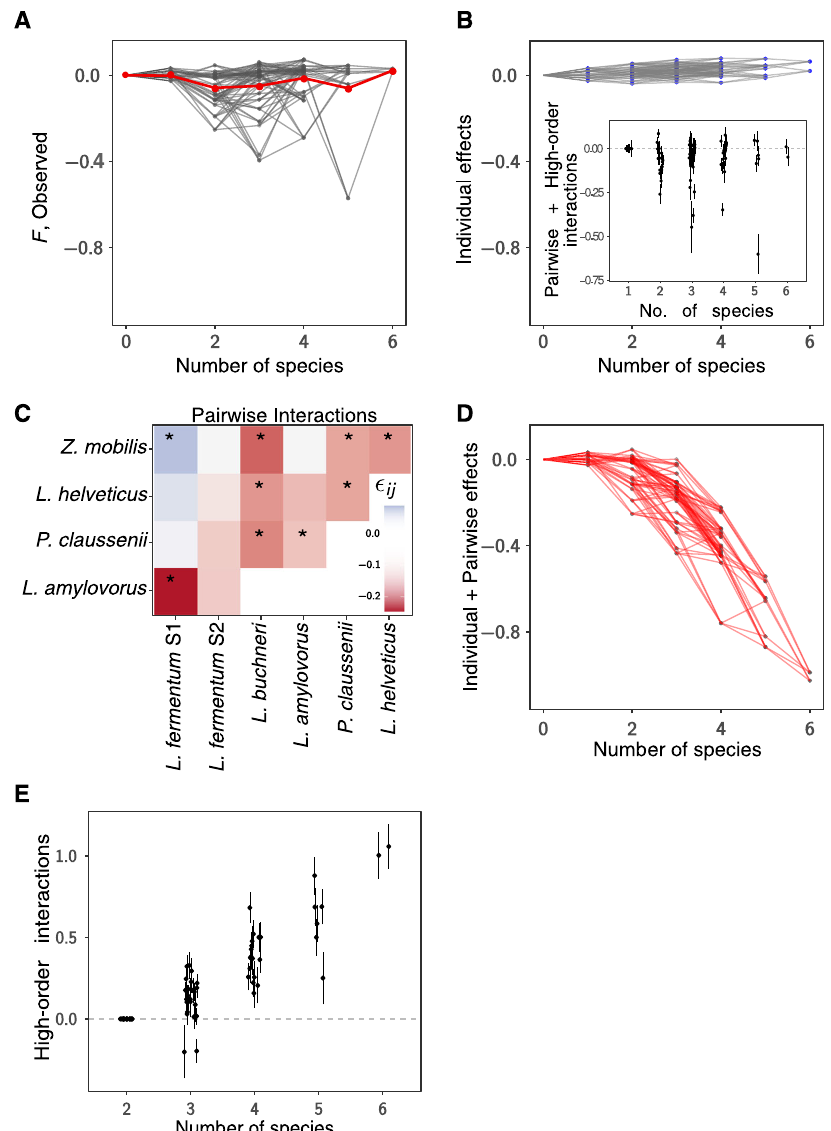
Fig. 3 The ecological interactions within the sugarcane biore fi nery microbial community. A Observed functional landscape. We plotted the measured function for communities of different species. Each line represents the effect of the addition of one species to a community. The red line represents the average of all points for each community size. B The expected functional landscape when considering the presence/absence (additive) null model. The inset shows the difference between the measured and predicted functions, plotted against community size, as a way to visualize the fi t of the data to the null model. Symbols and error bars represent the mean ± standard deviation. C Heat map showing the interactions among pairs of bacterial species (asterisks represent signi fi cance taking± 2SE). These interactions were diverse and mostly detrimental to ethanol yield. The epistasis difference (epsilon) between these species also suggests that such interactions are strain driven. D The functional landscape was predicted by adding up single and pairwise effects. This landscape predicts a rapid reduction in function as more species are added. E The difference between the prediction of the model in D is plotted against community size. For visualization, a jitter was applied to points of different composition but the same community size. The plotted difference effectively measures the in fl uence of high-order interactions. Symbols and error bars represent the mean ± standard deviation. For all the results presented in the fi gure, n = 3 independent experiments. Source data are provided as a Source Data fi